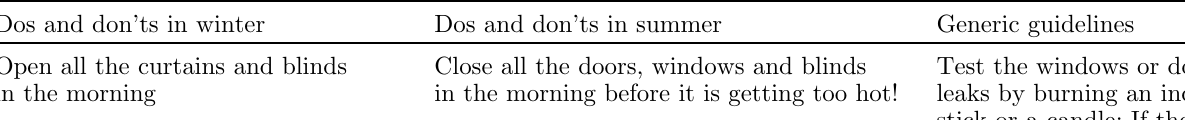
Table 2. Guidelines for energy conservation in social housing